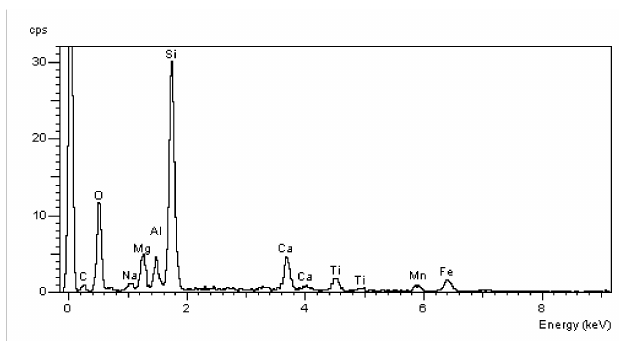
Figure 16. EDS spectrum of silicon dioxide glass